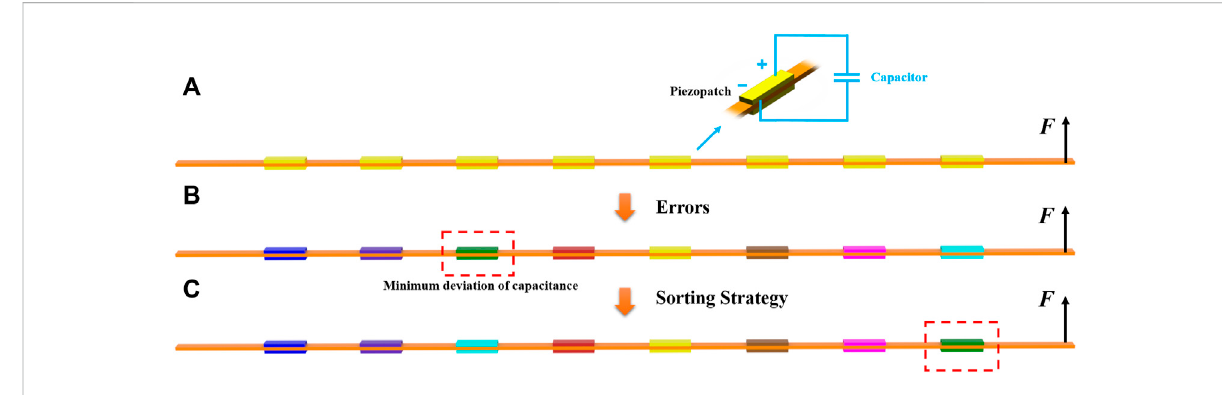
FIGURE 15 Example of a sorting strategy, (A) is a piezoelectric beam, all the piezopatch with a shunted capacitor in yellow are the same; (B) is the practical one with random errors in the capacitances; After the sorting strategy applied in (B) , the fi nal order is shown in (C)